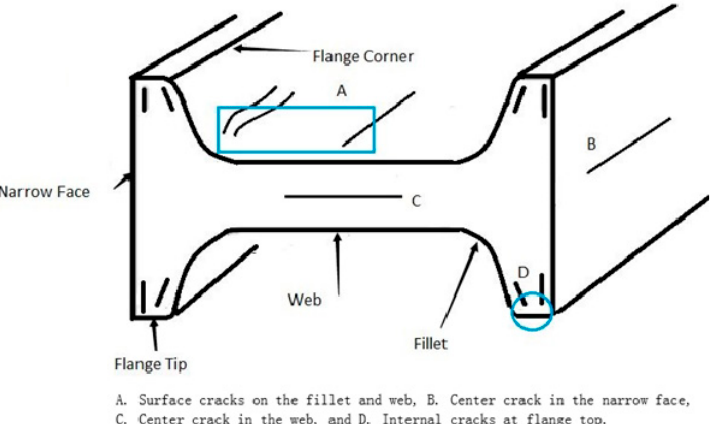
Figure 1. Cross-section schematic of a beam blank [5].